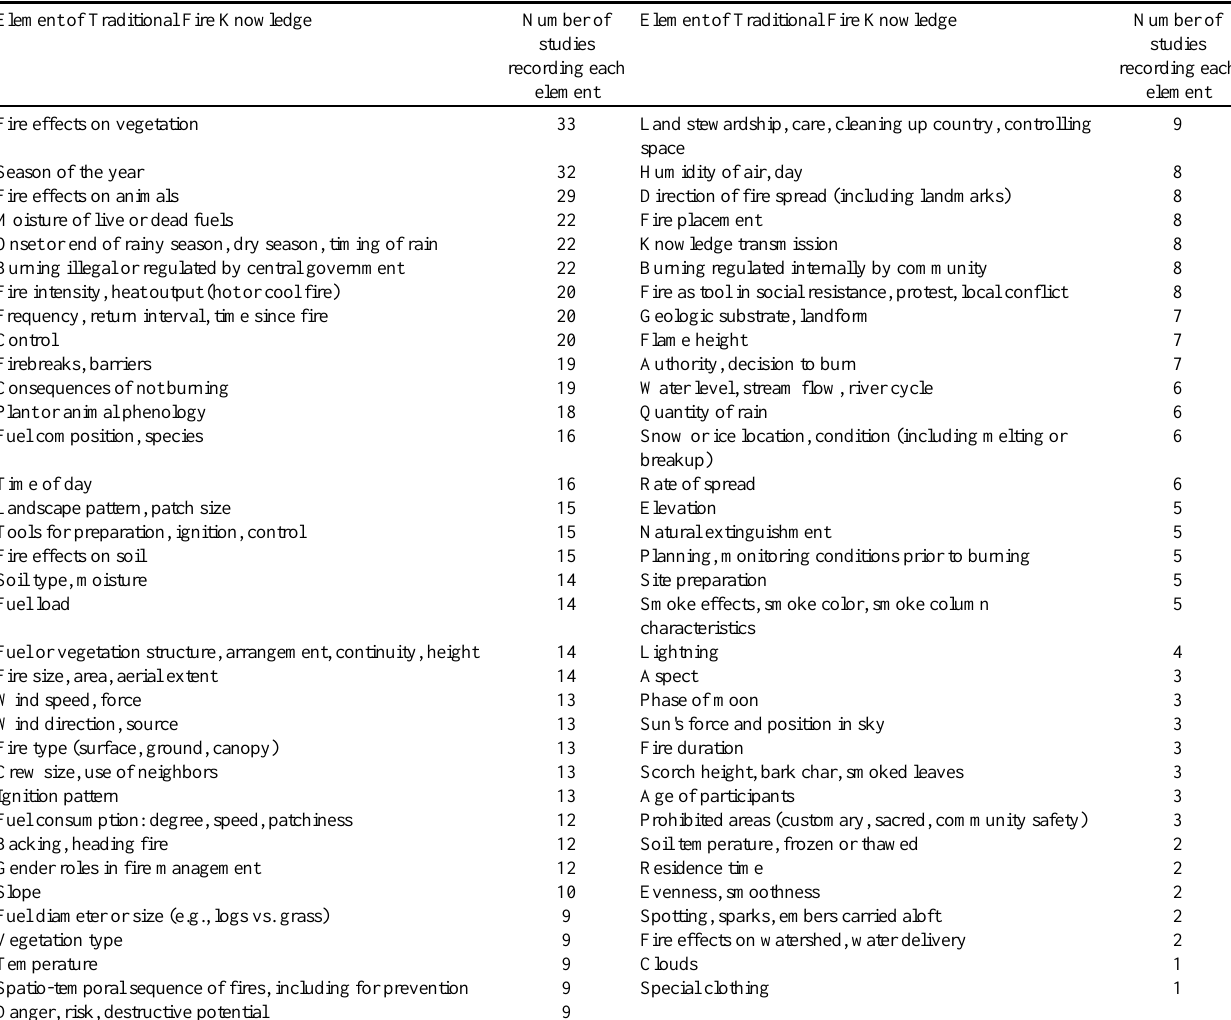
Table 2 . The most commonly recorded elements of traditional fire knowledge, sorted from the most common (top left) to the least common (bottom right). Elements were tallied from 35 studies that included accounts from 27 countries on 6 continents. Element of Traditional Fire